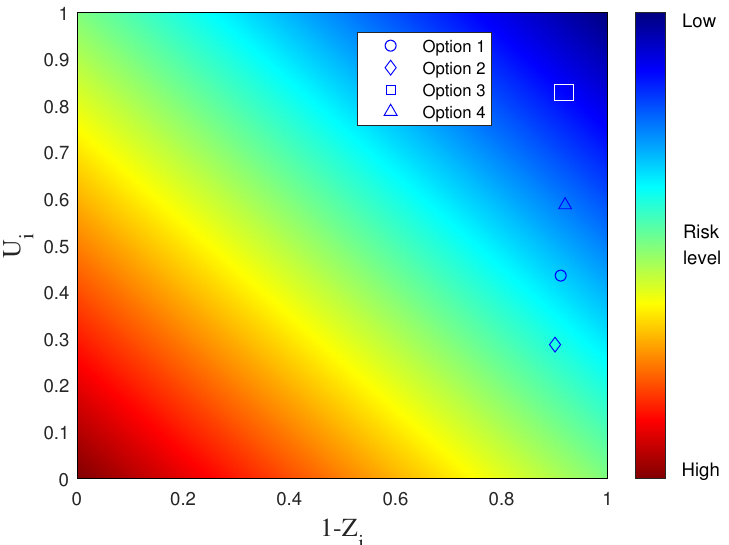
Figure 4. The risk level of each option in PRM and FMF